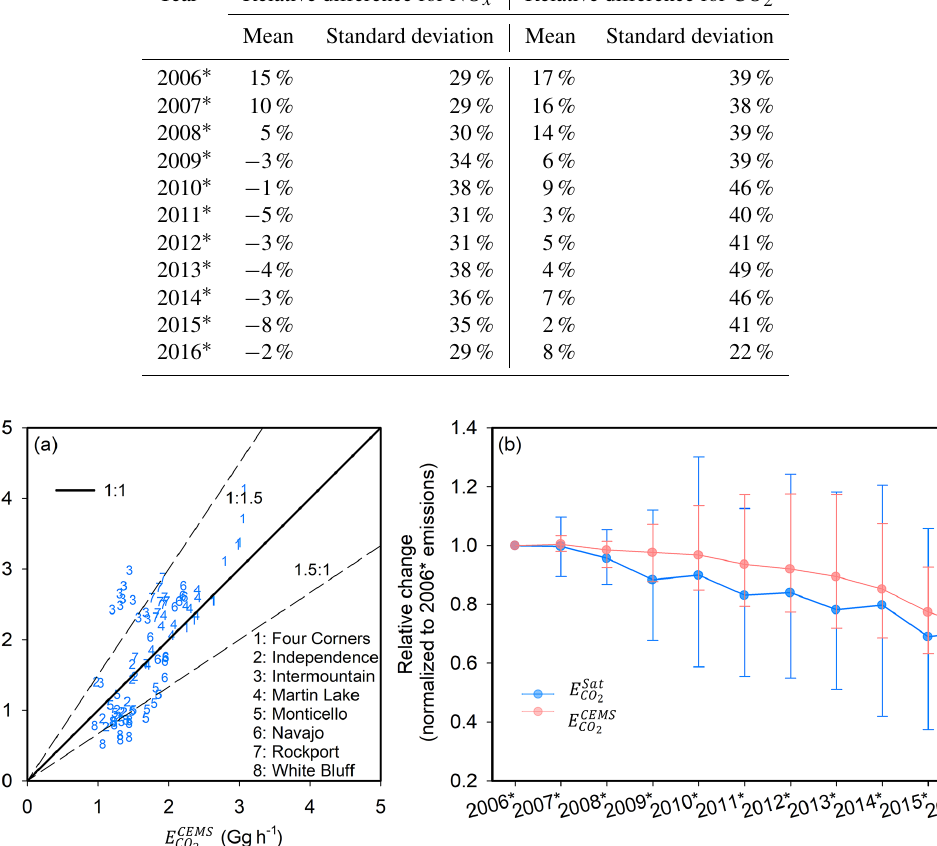
from 2006 ∗ to 2016 ∗ . The solid lines represent the ratio CO 2 (blue lines) and CO 2